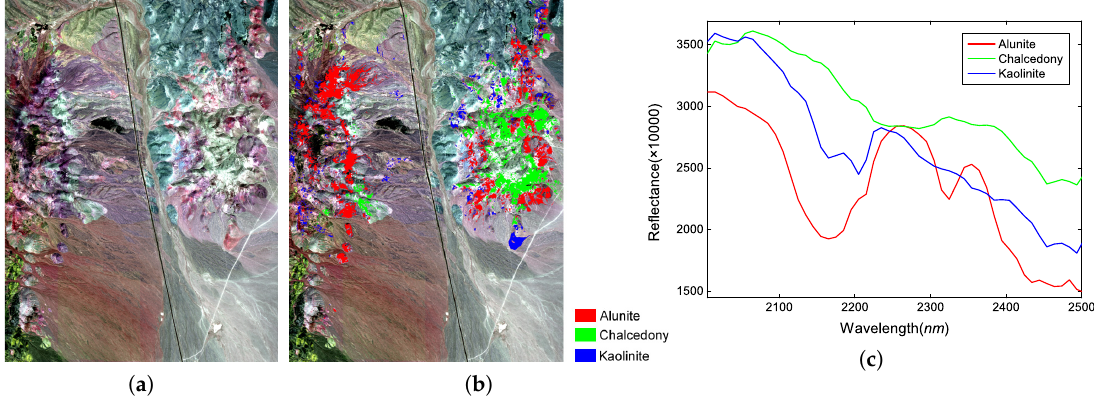
Figure 3. AVIRIS hyperspectral data acquired at Cuprite Mining District: ( a ) false-color image (R: band 183 (2095.0 nm ), G: band 193 (2195.0 nm), and B: band 207 (2334.6 nm); ( b ) reference mineral map for Alunite, Chalcedony, and Kaolinite of ( a ); ( c ) reference spectral signatures for Alunite, Chalcedony, and